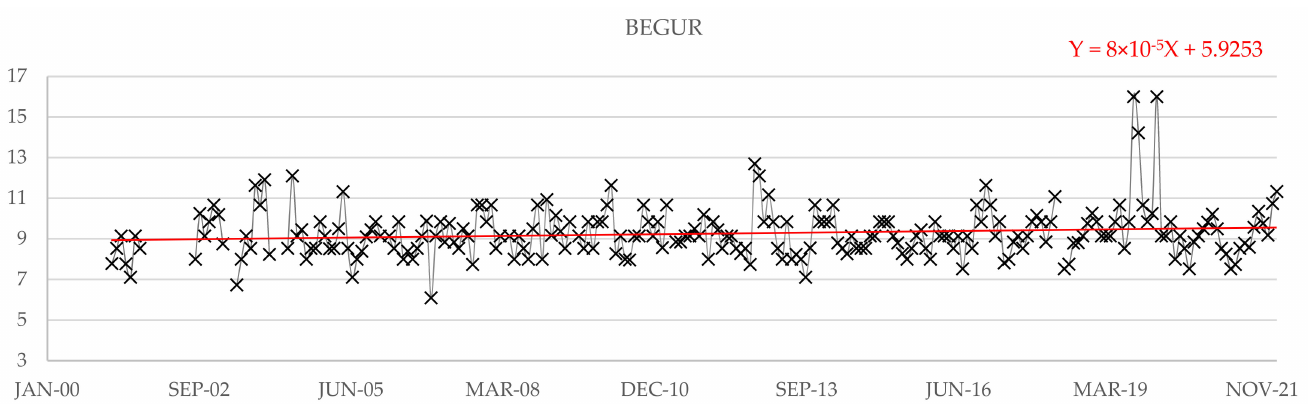
Figure 17. Evolution of Tp maxima in Tarragona.